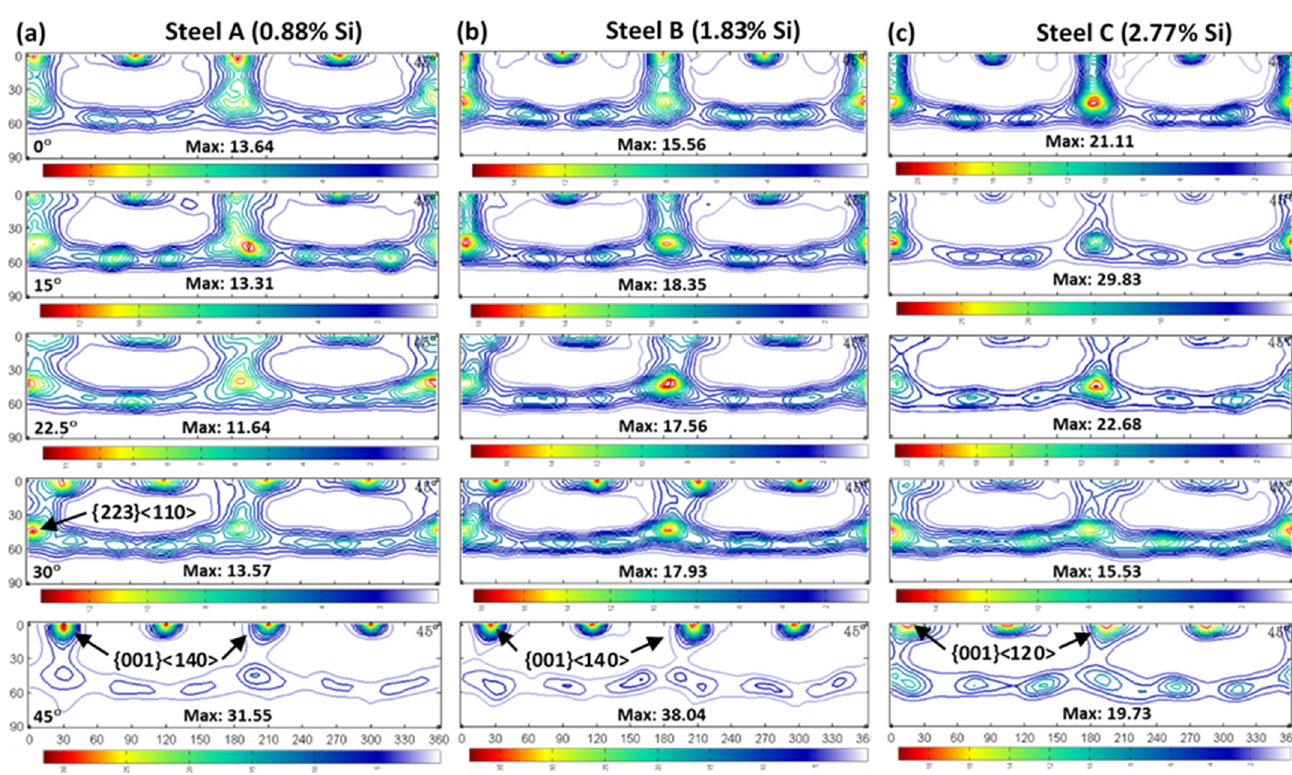
Figure 4. Textures after skew cold rolling with unidirectional feeding [26]: ( a ) Steel A, ( b ) Steel B and ( c ) Steel